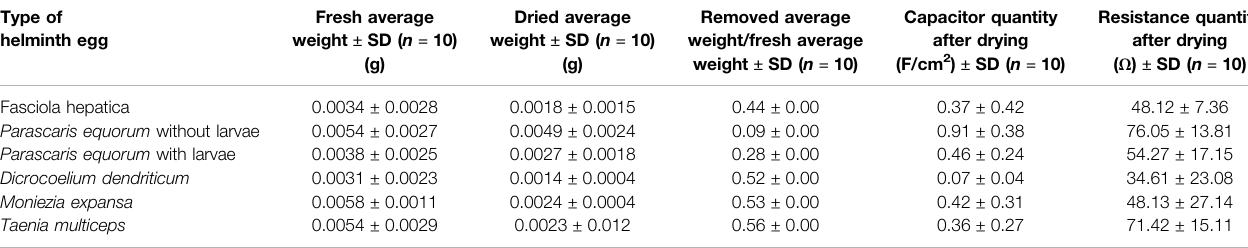
TABLE 2 | Effect of lost weight on the electrical